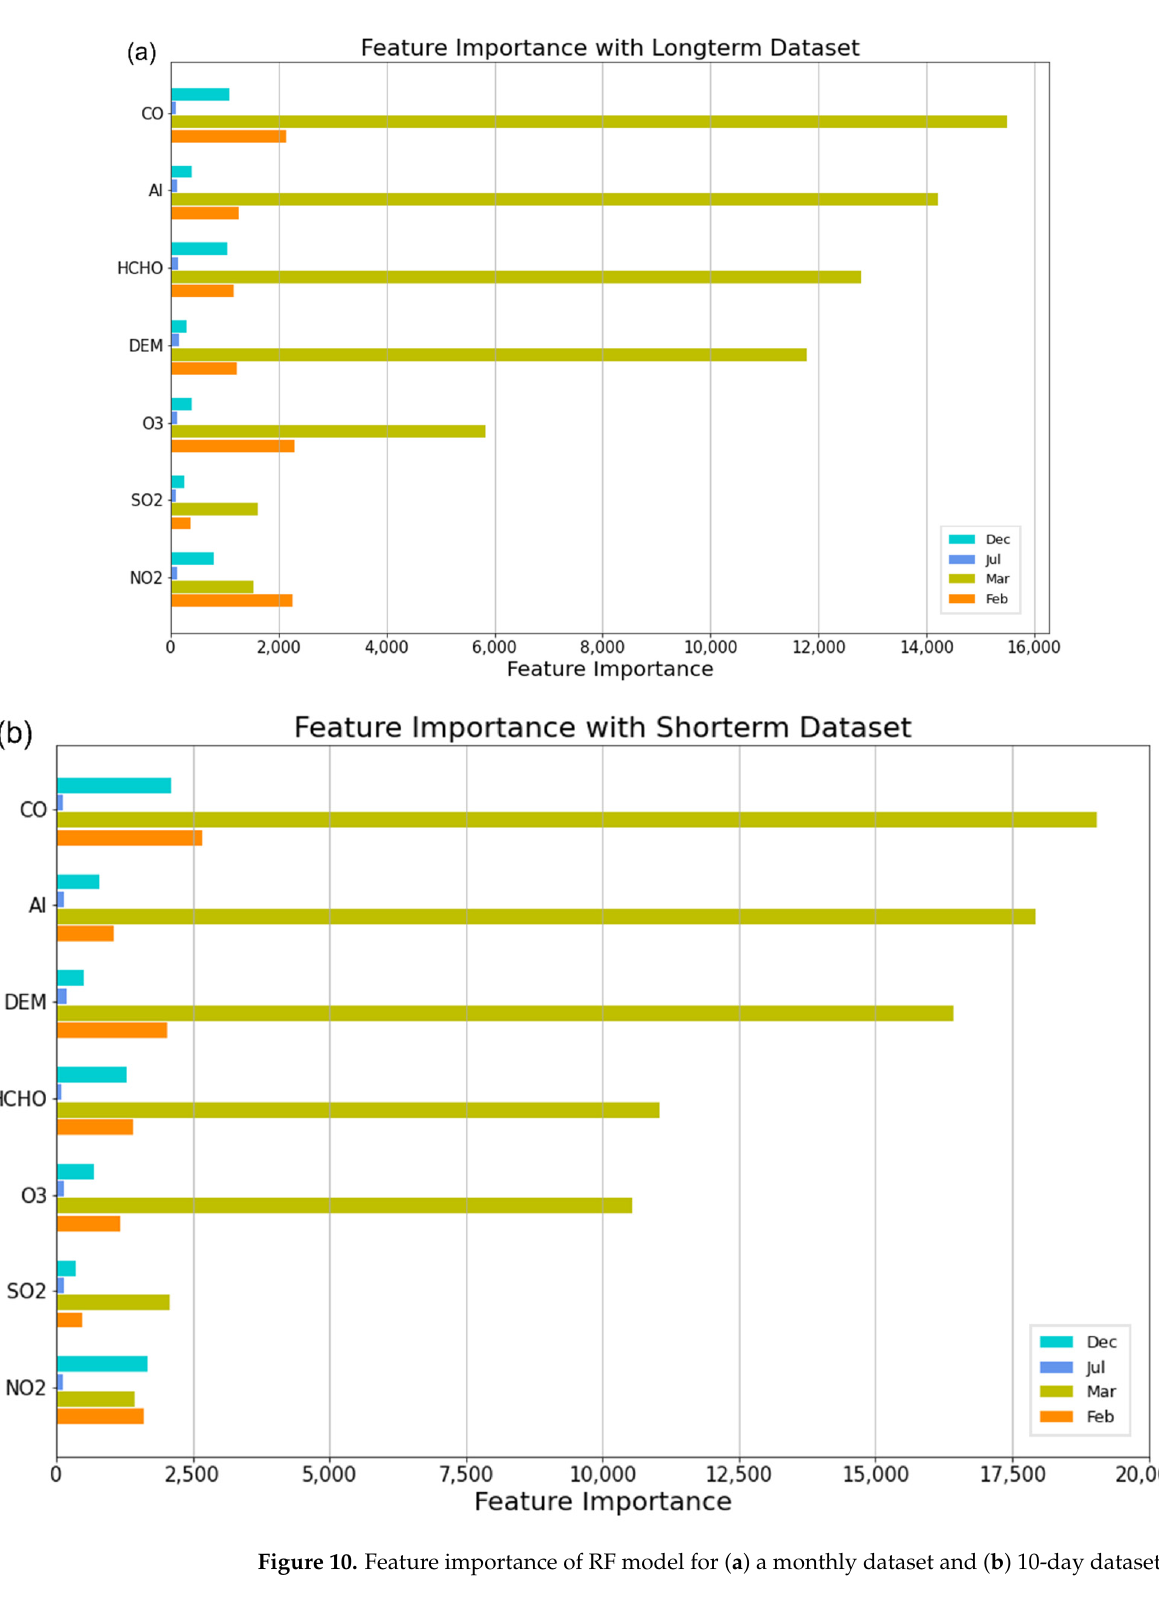
Figure 10. Feature importance of RF model for ( a ) a monthly dataset and ( b ) 10-day dataset.